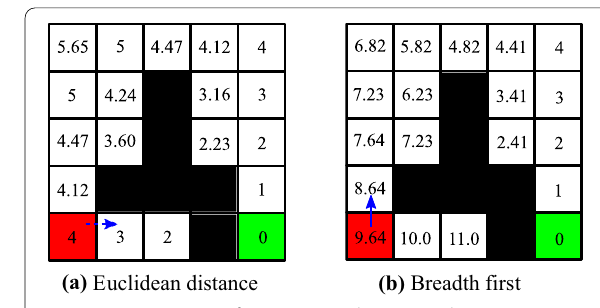
Figure 7 Single-step extended passable area extraction Figure 8 Comparison of environmental constraint